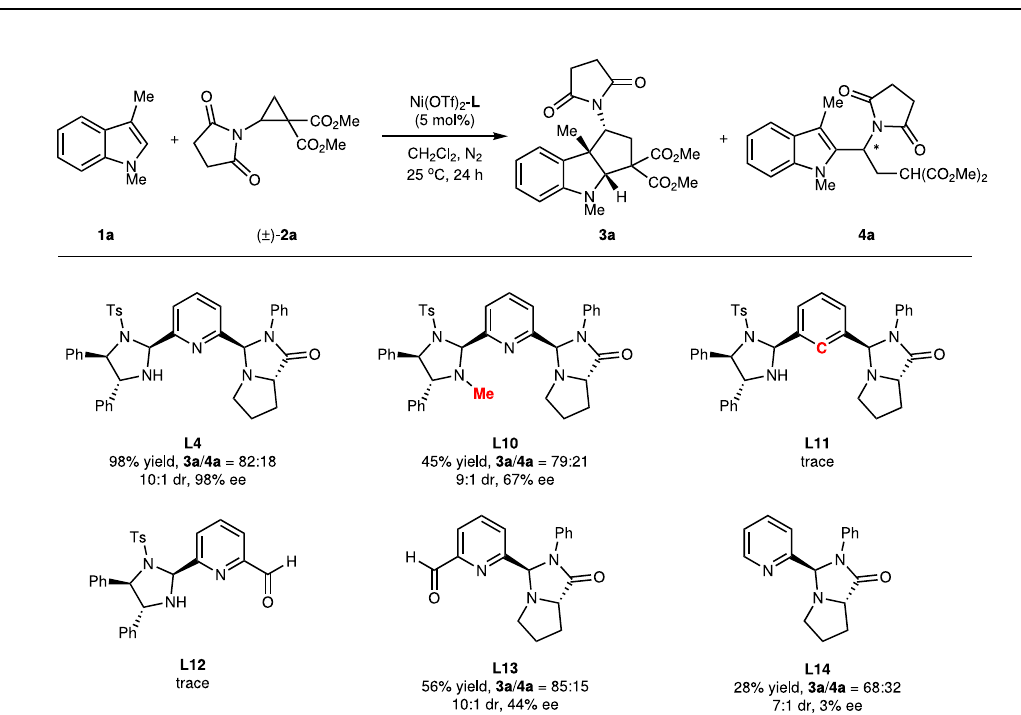
Fig. 4 | Kineticresolutionexperiment and scale-up reaction.a Kineticresolution experimentof3-methylindole 1a with aminocyclopropane 2a . b Gram-scalesynthesis of tricyclic indoline 3a